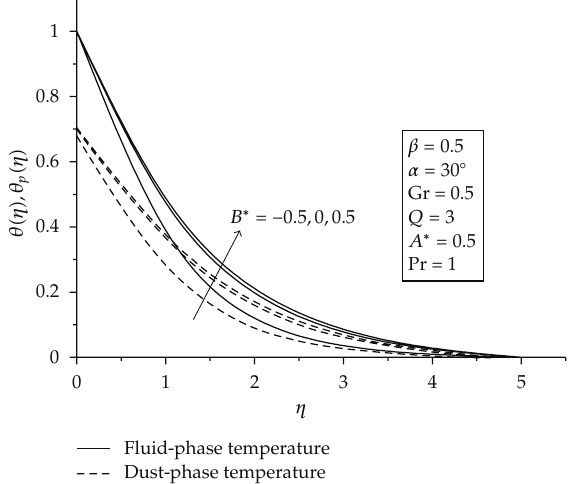
Figure 9: Temperature profile for di ff erent values of temperature-dependent heat